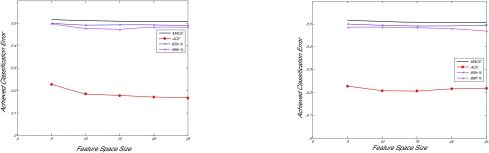
PACE analysis using a SVM-based classifier using the simple separability scoring criterion, with a 0.6 MAC threshold. Left Panel: performance without peak selection. Right panel: performance with peak selection.